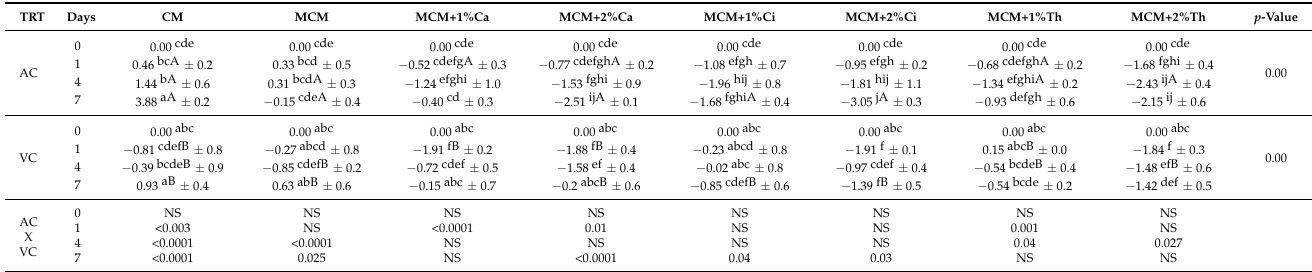
Table 7. Population changes of Enterobacteriaceae (log (N0/N) ± SD CFU/g) in marinated camel meat with essential oils under aerobic (AC) and vacuum (VC) conditions after storage at 4 ◦ C for 0, 1, 4 and 7 days.